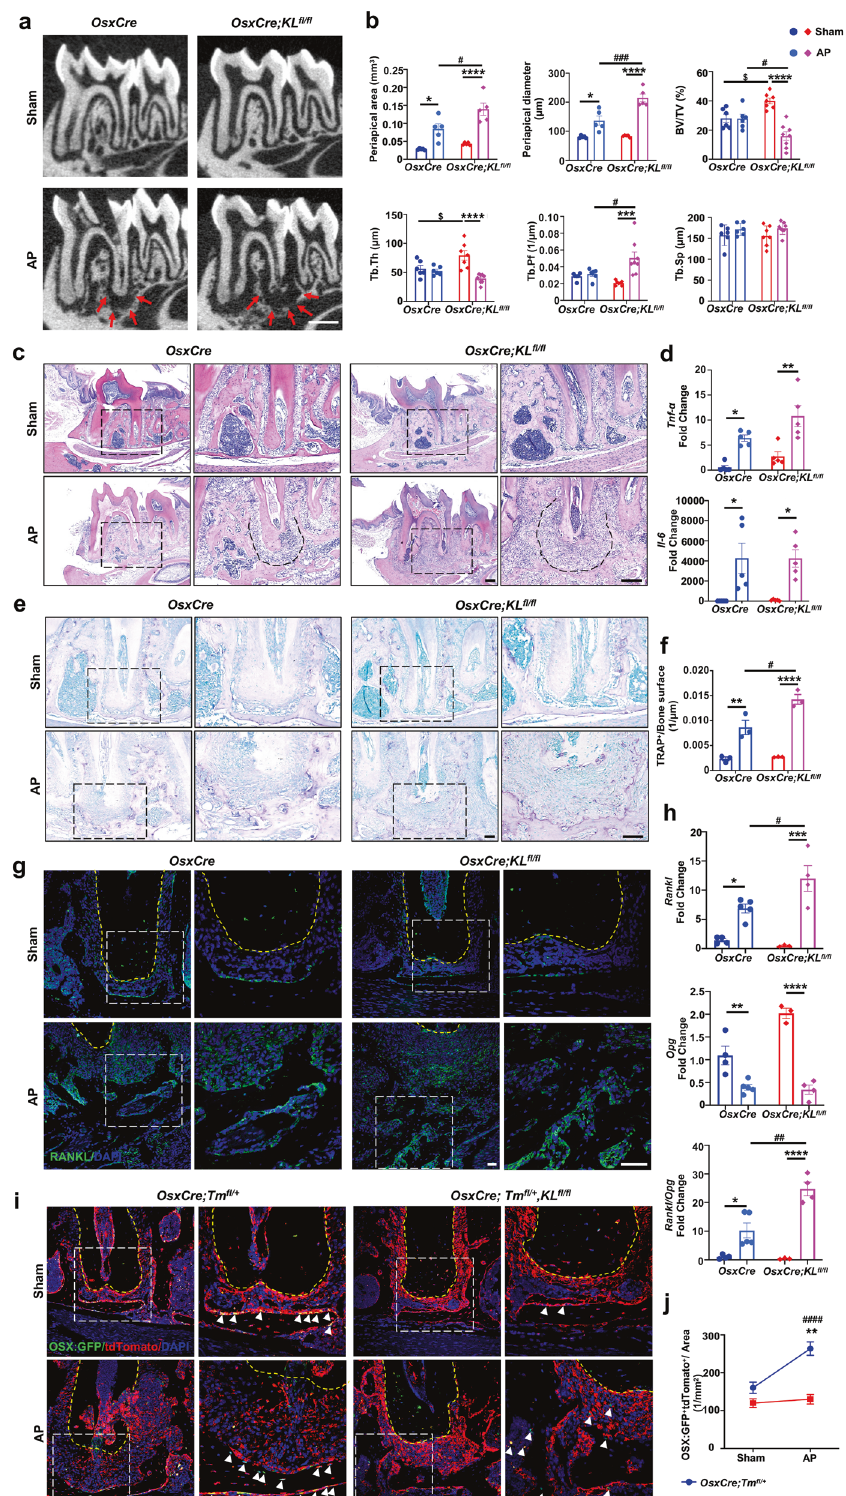
Human alveolar bone in apical periodontitis is associated with an altered Klotho expression pattern Klotho expression has been identi fi ed in a variety of human tissues, such as kidney, placenta, lung, pancreas, breast, para- thyroid gland, heart, vasculature, brain, and several endocrine Signal Transduction and Targeted Therapy (2022)